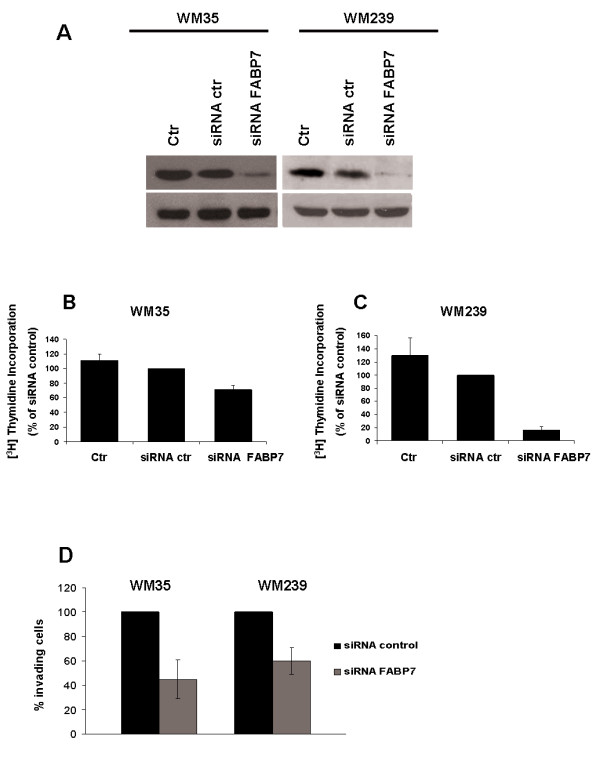
A) Western blot analysis showing down-regulation of FABP7 in WM35 and WM239 cells after transfection with FABP7 siRNA, with α-tubulin as loading control.B-C) The effect of FABP7 down-regulation on proliferation in WM35 (B)and WM239 (C)cells measured by [3H]Thymidine incorporation 72 hrs post transfection. Down-regulation of FABP7 protein using siRNA led to reduction of DNA synthesis, suggesting reduced proliferation in both cell lines.D) Matrigel invasion assay. Inhibition of invasion ability of WM35 and WM239 cells following FABP7 down-regulation with siRNA. The average was calculated from three independent experiments and presented with standard deviation.